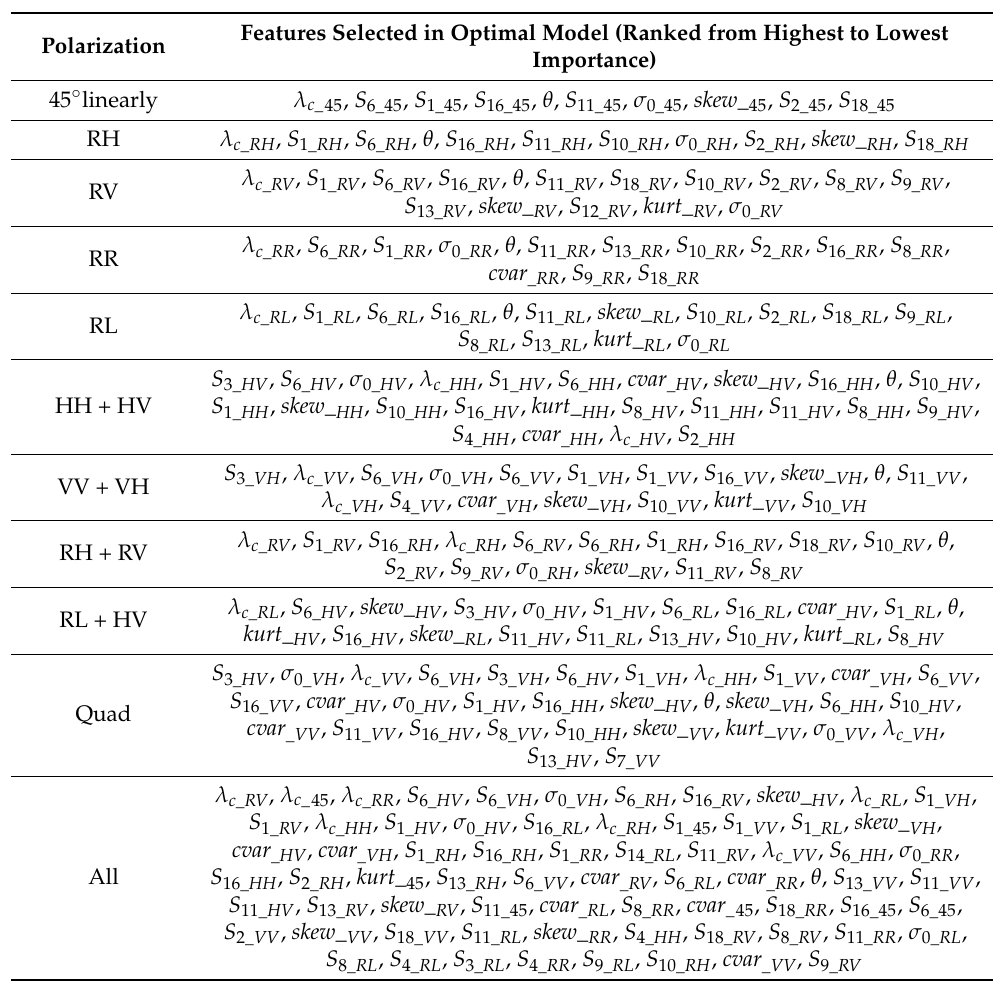
Table A1. Cont. Features Selected in Optimal Model (Ranked from Highest to Lowest Polarization